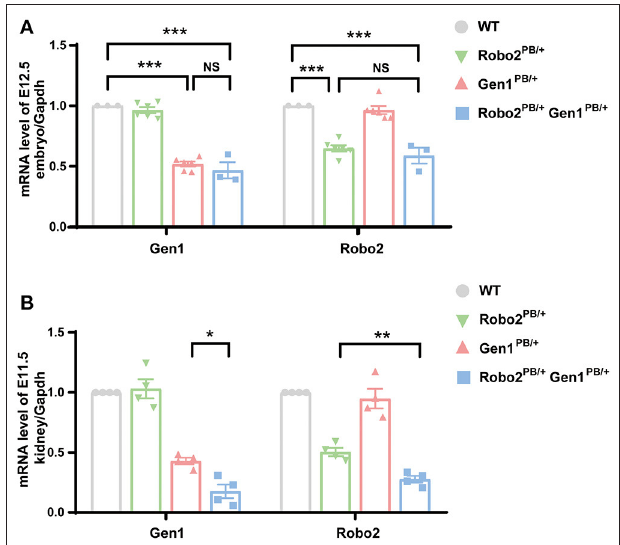
FIGURE 1 | Expression of Robo2 and Gen1 in the WT, Robo2 PB / + , Gen1 PB / + and Robo2 PB / + Gen1 PB / + mice. (A) Expression levels of Gen1 and Robo2 in E12.5 whole WT, Robo2 PB / + , Gen1 PB / + , and Robo2 PB / + Gen1 PB / + mouse embryos. N = 3 WT, Robo2 PB / + and Robo2 PB / + Gen1 PB / + embryos each; N = 5 Gen1 PB / + embryos. (B) Expression levels of Gen1 and Robo2 in kidneys from E11.5 WT, Robo2 PB / + , Gen1 PB / + and Robo2 PB / + Gen1 PB / + mice. N =